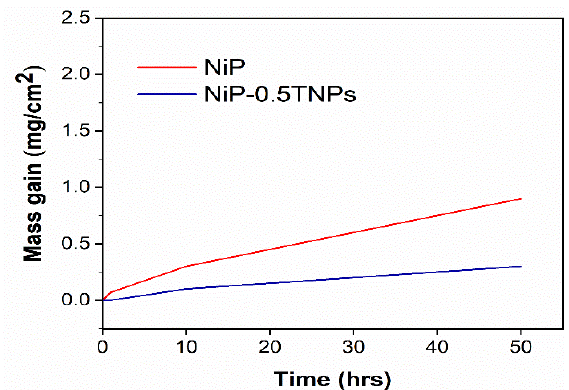
Figure 13. Mass gain vs. time graph for NiP and NiP-0.5TNPs coatings heat-treated at 400 °C in air.